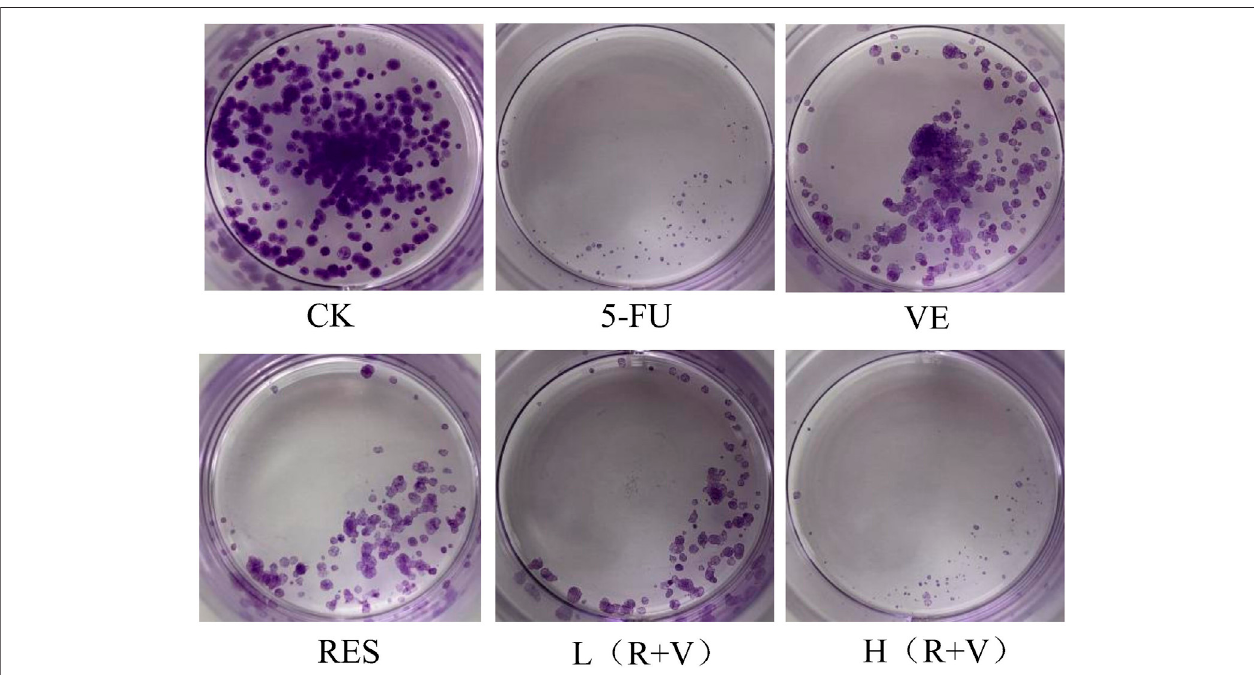
FIGURE 3 | The in fl uence of resveratrol (RES), Vitamin E (VE), and their combination on cell clone formation.